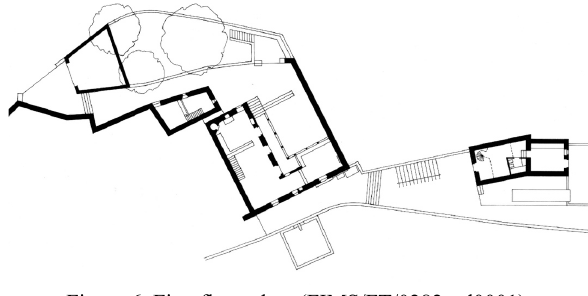
Figure 6. First floor plan. (FIMS/FT/0282-pd0001).